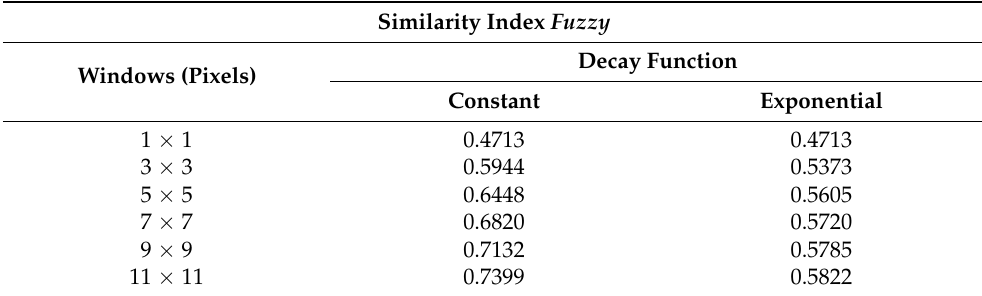
Table 4. Fuzzy similarity indices obtained from the constant and exponential decay functions for different window sizes in the periods between 2009 and 2014.